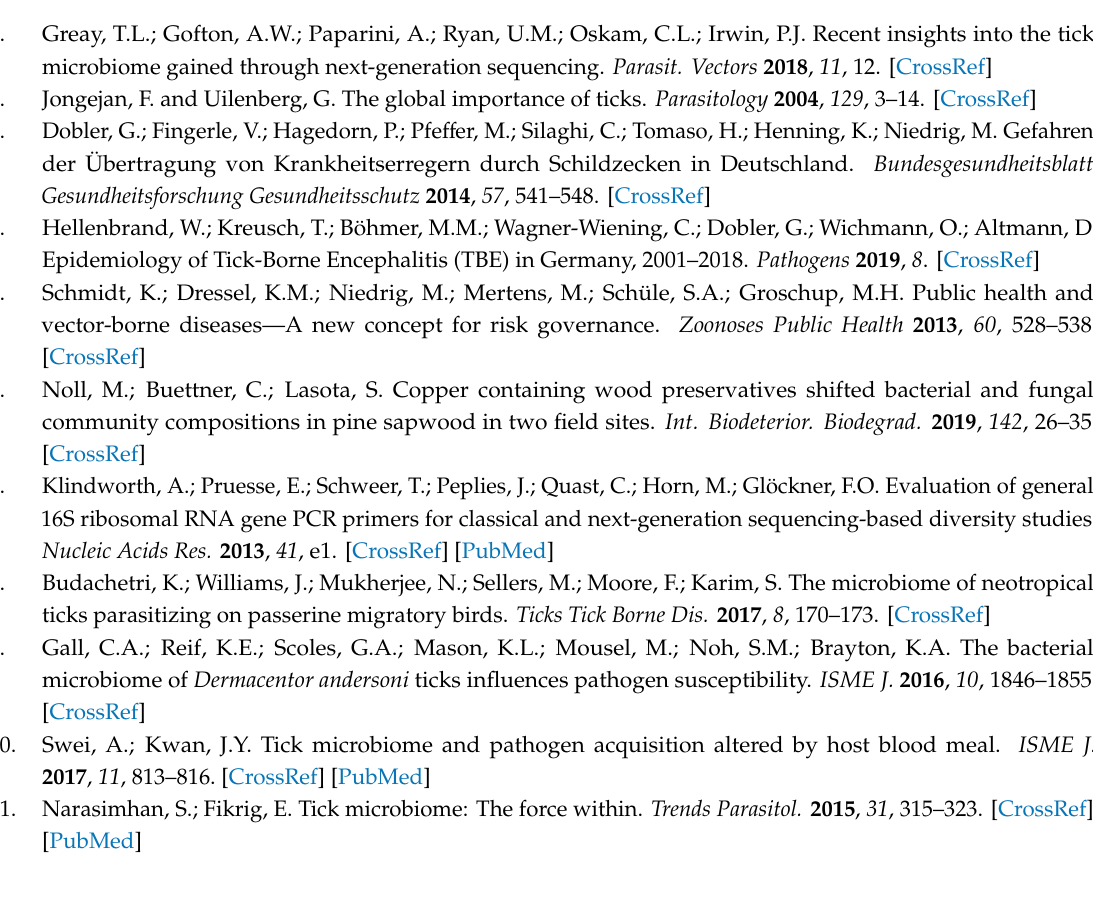
Figure S1: Bray-Curtis-Similarity heatmap and cluster analysis summarized on genus level of relative abundances for DNA samples (A) and cDNA samples (B) of 70% ethanol (DKA1; red), DNA Away (DKA2; orange), 5% sodium hypochlorite (DKA3; yellow) and RSDL (DKA4; blue) decontaminated ticks. PC (positive control; green) without decontamination and NC (negative control; see color of decontamination treatment + black point) ticks without contamination. Replicates of each treatment are numbered after respective acronym. Details of treatments and replicates are summarized in Table 1. Figure S2: Euclidean distance matrix based on ward.D2 method and bacterial community composition on genus level for DNA (A) and cDNA samples (B) of 70% ethanol (DKA 1), DNA Away (DKA 2), 5% sodium hypochlorite (DKA 3) and RSDL (DKA 4) decontaminated ticks. PC (positive control) without decontamination and NC (negative control) ticks without contamination. For colors and patterns see figure legend. Bacterial community composition of contaminants on genus level are denoted and other genera are summarized as “others” for non-contaminants. For clusters, heights of 1 were chosen and denoted in black boxes. Replicates of each treatment are numbered after respective acronym. Details of treatments and replicates are summarized in Table 1. Table S1: OTU count table for sequence reads of this study for DNA and cDNA samples a ffi liated to publicly available sequences found from human sweat and dog saliva. Table S2: OTU count table for DNA samples. Table S3: OTU count table for cDNA